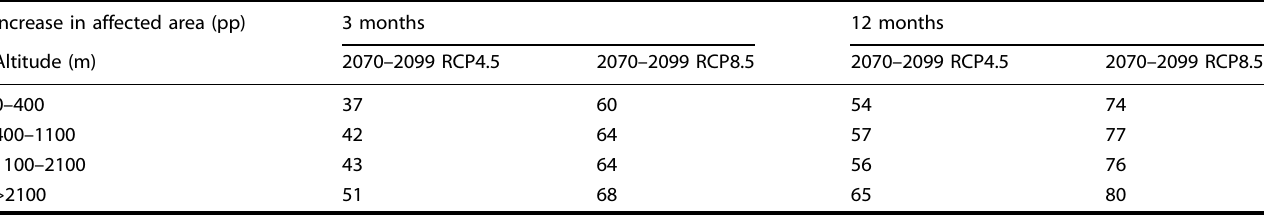
Table 1. Changes (percentage points, pp) in area affected by drought (SPEI < – 1) by altitude intervals, in the future period (2070 – 2099), under RCPs 4.5 and RCP8.5, relative to the baseline (1980 –